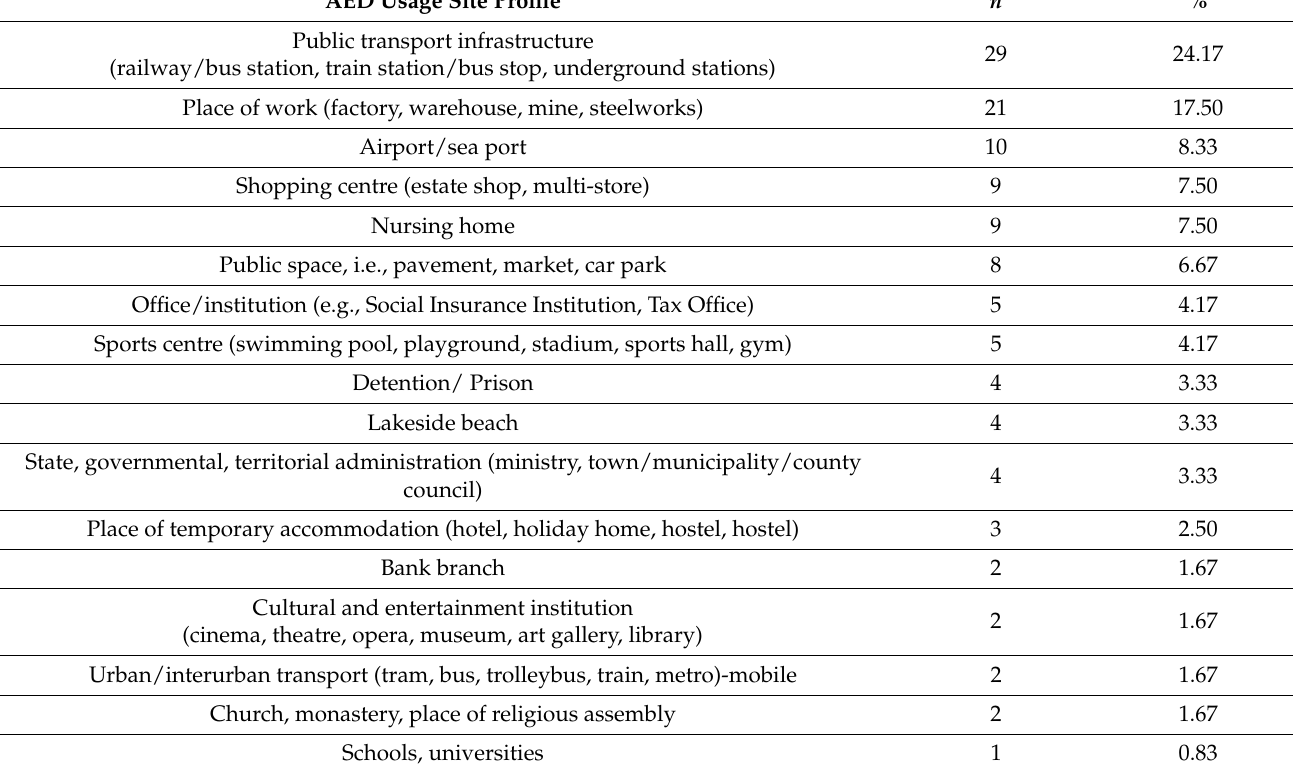
Table 4. AED device location profile ( n =